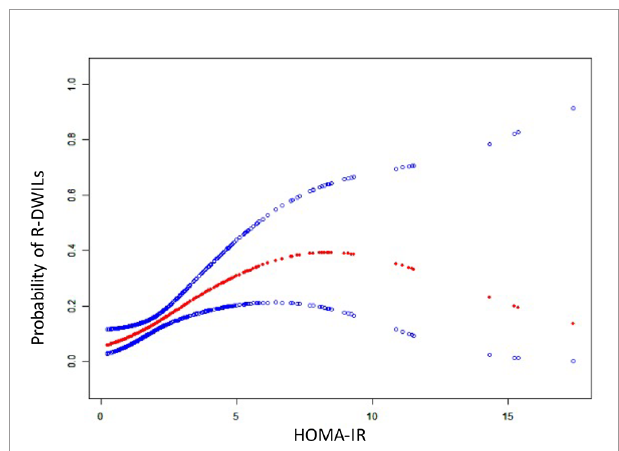
FIGURE 4 | The relationship between HOMA-IR and the probability of R-DWILs. A nonlinear relationship between HOMA-IR and the probability of R-DWILs was observed after adjusted for age, gender, body mass index, National Institutes of Health Stroke Scale score, history of hypertension, history of diabetes mellitus, ventricle extension, total cerebral small vessel disease score and antiplatelet use. The probabilities and 95% CIs of R-DWILs occurrence are shown in red dotted line and blue dotted lines respectively.